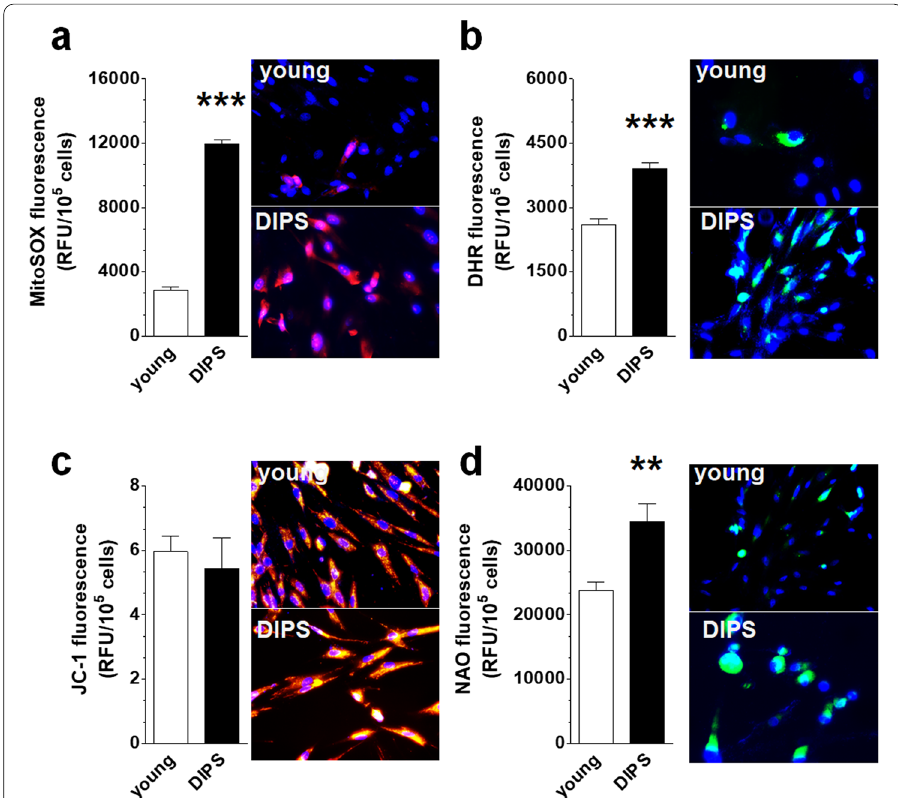
Fig. 5 Analysis of oxidative stress determinants during DIPS of HGSOCs. Changes in the production of mitochondrial superoxide ( a ), cellular peroxides ( b ), mitochondrial membrane potential ( c ), and mitochondrial mass ( d ) quantified according to the fluorescence of MitoSOX Red, DHR, JC‑1, and NAO, respectively. As per mitochondrial membrane potential measurements, JC‑1 accumulates in the functional mitochondria, forming red fluorescent J‑aggregates (at 590 nm), while mitochondria de‑energization results in the accumulation of green fluorescent monomers (at 535 nm). The rise in the green/red fluorescence intensity ratio indicates a drop of the mitochondrial membrane potential values. The results are based on 8 independent experiments using HGSOCs obtained from different patients. The results are expressed as the means SEM. ** p < 0.01; *** p < 0.001 vs. young cells. RFU relative fluorescence ±